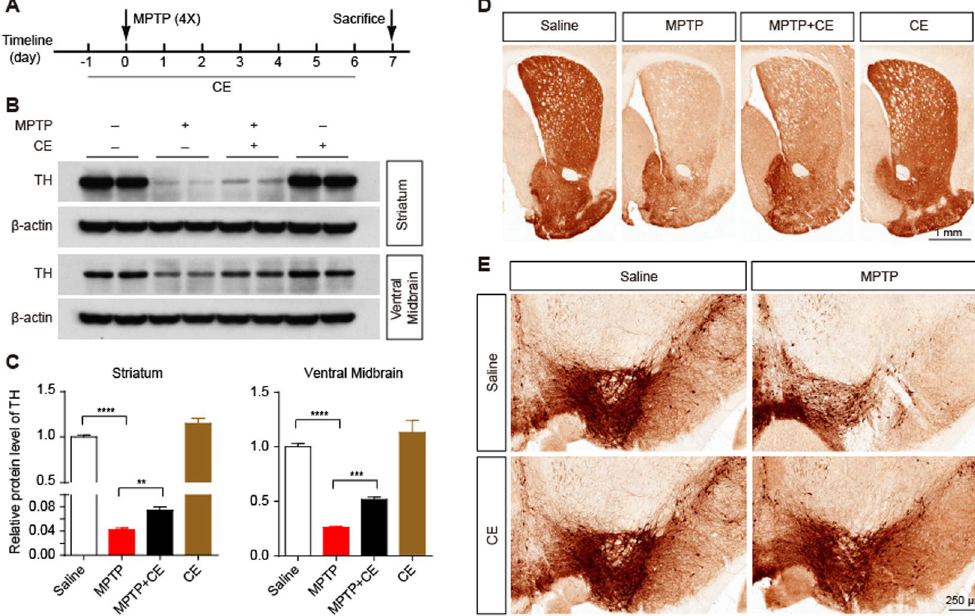
Figure 6. Neuroprotective effect of CE on a mouse model of MPTP-induced PD. ( A ) Schematic representation of the establishment of the PD mouse model and CE treatment. Adult C57BL/6 J mice were intragastrically administered 10 mg/kg CE or saline 12 h before receiving intraperitoneal injections of 20 mg/kg MPTP (4 times, 2 h intervals); mice were continuously treated with CE or saline until sacrifice. ( B ) Seven days after the MPTP injections, mice were sacrificed and the striatum and ventral midbrain tissues were dissected. The tissue lysates were immunoblotted with an anti-TH antibody to examine the loss of dopaminergic neurons. ( C ) Quantification of TH protein levels (normalized to β -actin). ( D and E ) The striatum and substantia nigra were visualized using immunohistochemical staining with an anti-TH antibody. Data are shown as mean ± SEM, n = 4 mice per group. One-way ANOVA followed by Tukey’s multiple comparisons test. ** p < 0.01, *** p < 0.001. Scale bar, 1 mm (upper right) and 250 μ m (bottom